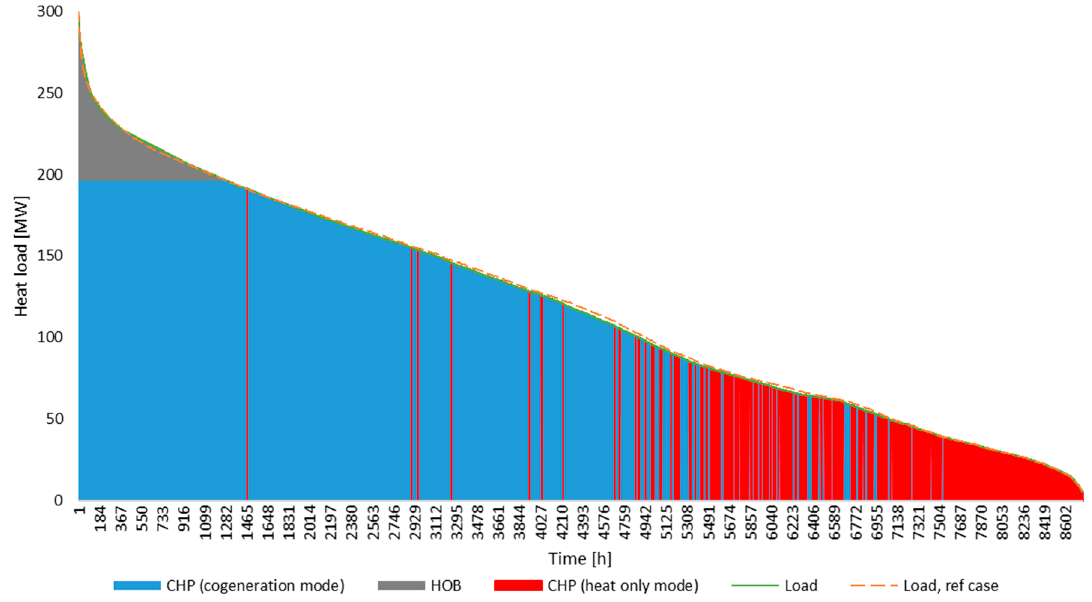
Figure A3. Heat load curve in Case 2 when HWT is not included in the DH system. Load in the reference case is also illustrated as a dashed line.